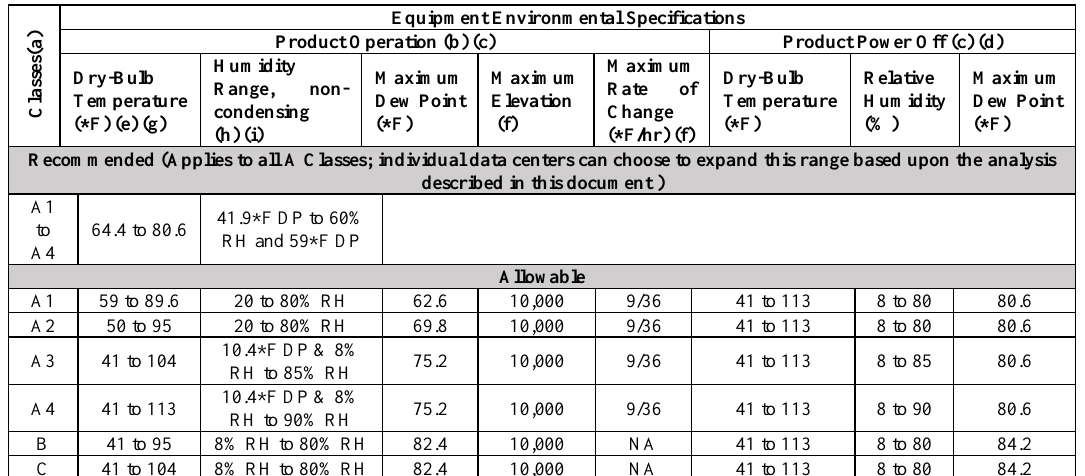
Table 1. Temp & RH suggested by ASHRAE (TC,